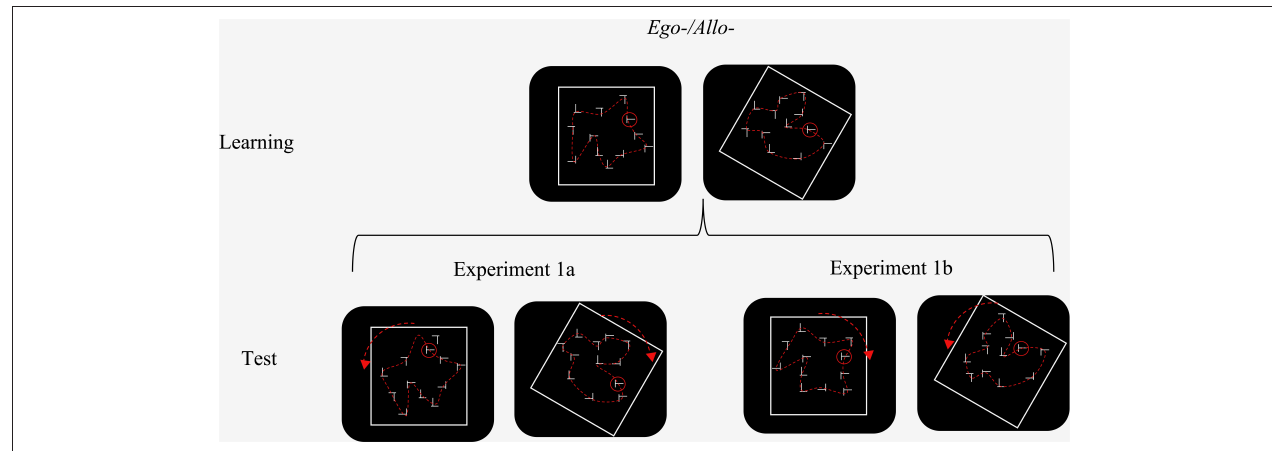
FIGURE 3 | The difference between Experiment 1a and Experiment 1b in the “ Ego–/Allo– ” condition. In Experiment 1b, half of the target positions from the learning phase coincided with the other half of the target positions after rotation to remove the confound of unequal target location probabilities. In the actual experiment, the circle marking the target and the imaginary layout were not